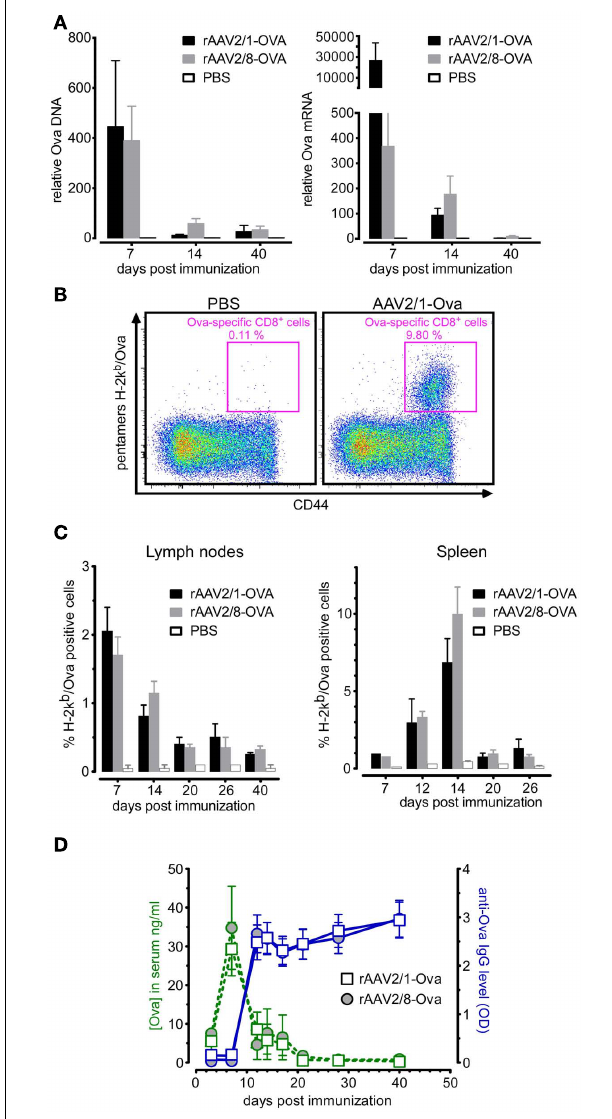
FIGURE 1 | Characterization of anti-Ova immune responses following muscle gene transfer using rAAV2/1-Ova or rAAV2/8-Ova. Group of four to seven mice were injected with titrated 1 × 10 11 viral genomes (vg) of either rAAV2/1-Ova or rAAV2/8-Ova in the gastrocnemius muscles at day 0 and then culled at different time points. (A) Gastrocnemius muscles were analyzed for the presence of Ova DNA and mRNA by qPCR and qRT-PCR, respectively, at 7, 14, and 40days post-gene transfer. (B) Representative flow cytometry profile and (C) bar graphs showing the percentage of Ova-specific CD8 + T cells positively stained with H-2K b /Ova pentamers in draining lymph nodes and spleen at different time points after gene transfer. (D) Sera were harvested from individual mice at different time points and analyzed by ELISA for the detection of sOva (green lines) and anti-Ova IgG (blue